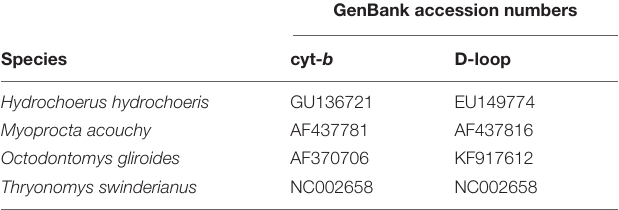
TABLE 3 | List of species for which a total of 128 sequences were obtained from the GanBank database, and used in phylogenetic